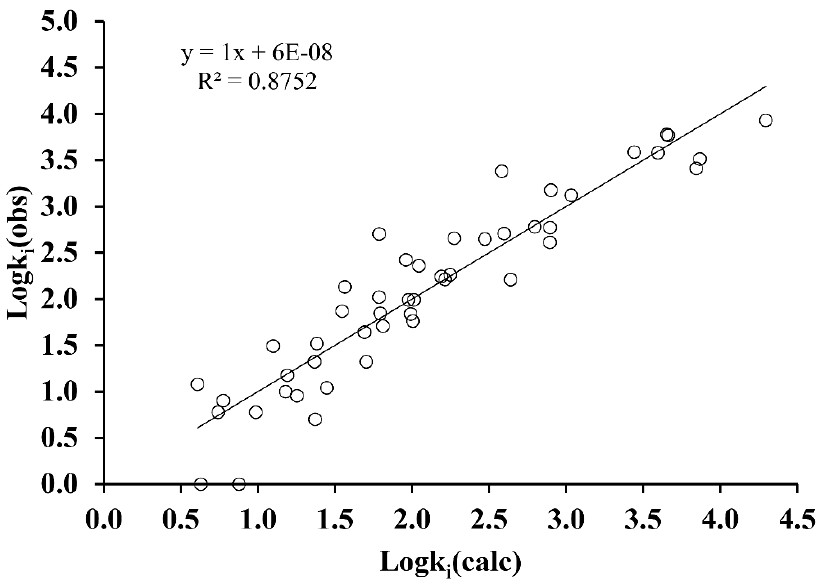
Figure 3. Graphical representation of Logk i (obs) versus Logk i (calc) obtained from Equation (2). The randomness test performed at Equation (2) shows excellent stability thereof (see Figure 4).